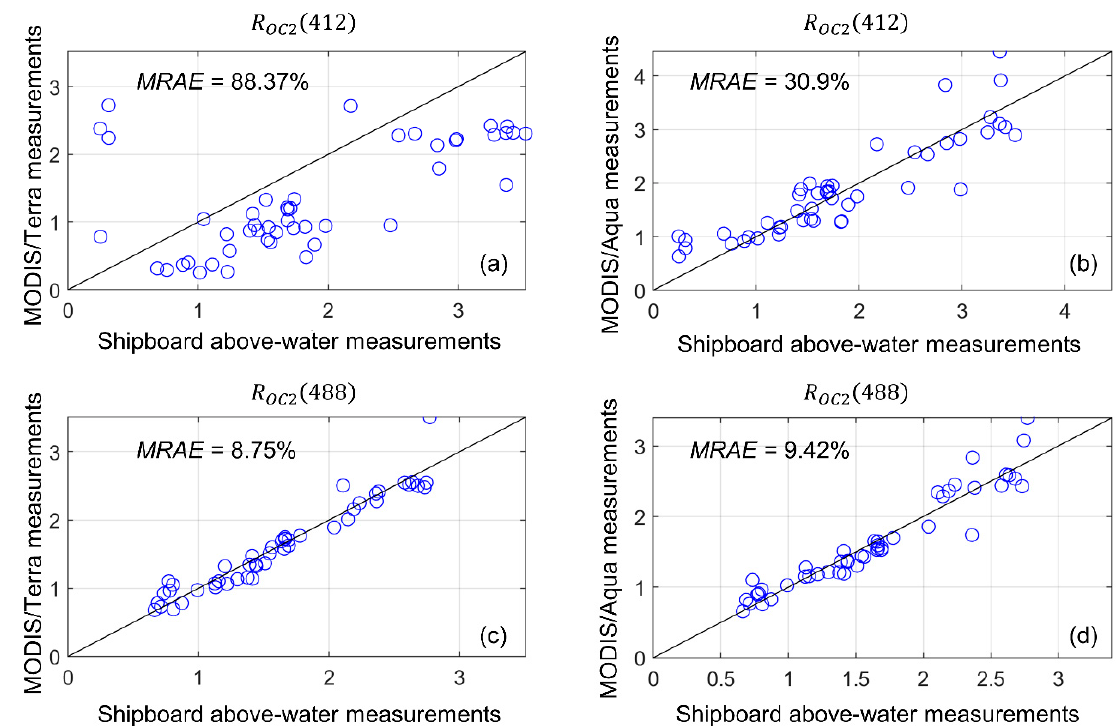
Figure 4. Quality analysis of the atmosphere correction of satellite data. Examples of the comparison of ship and satellite estimations of R OC 2 . Left column shows MODIS/Terra measurements ( a , c ), right column shows MODIS/Aqua measurements ( b , d ).